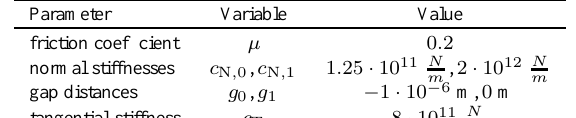
Table 3 Determined contact parameters for best match of simulated with